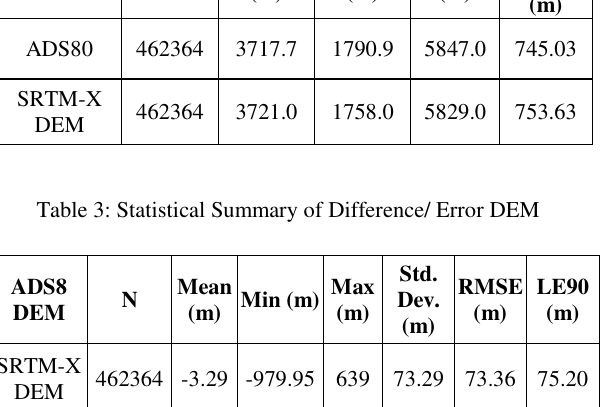
Table 2: Statistics related with the used DEMs DEM Used